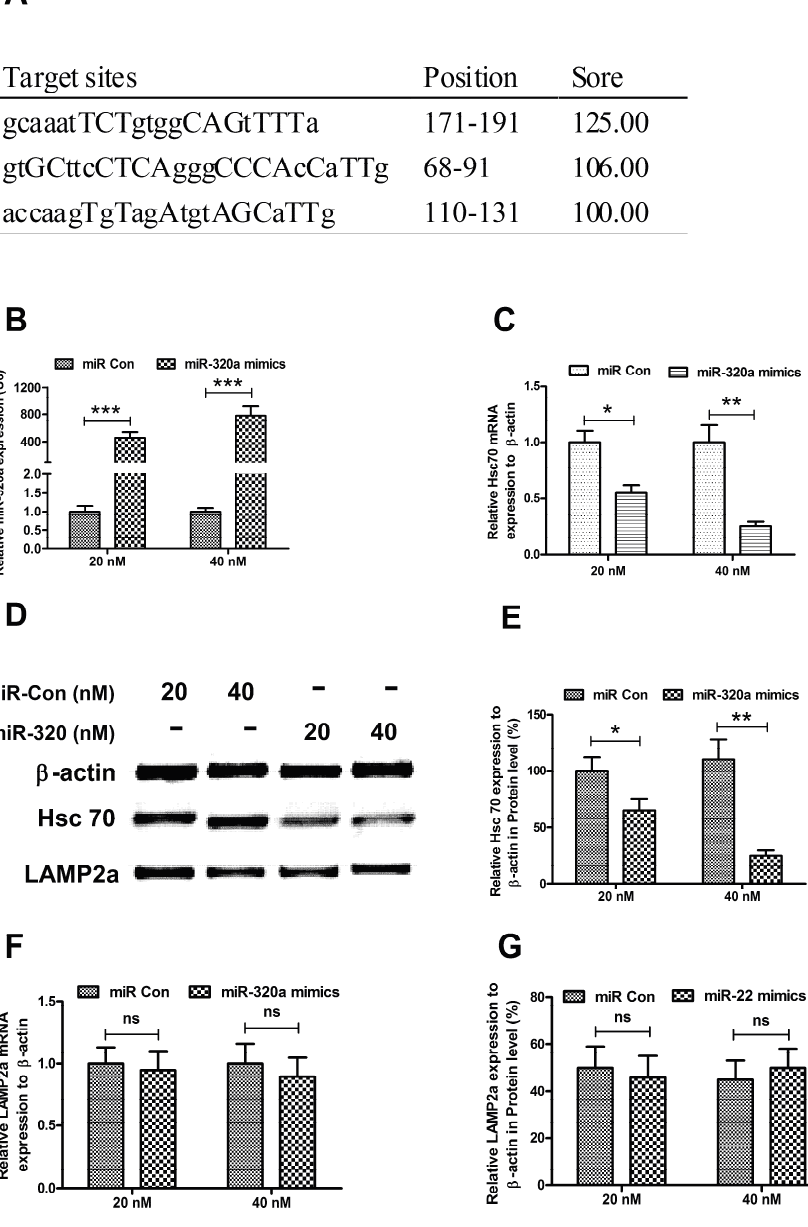
Figure 3. MiRNA-320a downregulates Hsc 70 expression in SH-SY5Y-Syn(+) cells. ( A ) Potential targeting sites in 3' UTR of Hsc 70, predicted by miRTarBase; ( B) Significant promotion of miR-320a level by miR-320a mimics transfection in the SH-SY5Y-Syn(+) cells; ( C ) Down-regulation of Hsc 70 in mRNA level by miR-320a mimics transfection in the SH-SY5Y-Syn(+) cells; ( D ) Western blot analysis of Hsc 70 and LAMP2A in SH-SY5Y-Syn(+) cells post miR-320a mimics or miRNA control transfection; ( E ) Significant downregulation of Hsc 70 in protein level by miR-320a mimics transfection; ( F ) LAMP2A expression in mRNA level in SH-SY5Y-Syn(+) cells post miR-320a mimics or miRNA control transfection; and ( G ) LAMP2A expression in protein level in SH-SY5Y-Syn(+) cells post miR-320a mimics or miRNA control